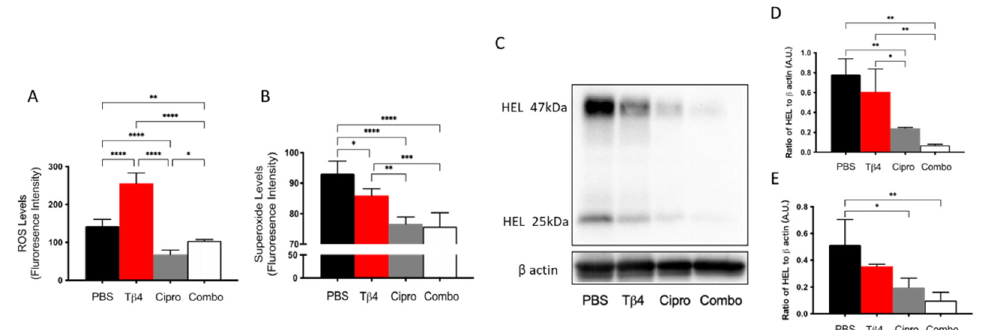
Figure 3. In vivo assessment of oxidative stress in corneal lysates following 3 days of P. aeruginosa - induced infection. Results for ROS ( A ) and superoxide production ( B ) are presented as mean fluorescence intensity ± SD. Western blot was used to detect the reactive species-induced lipid peroxidation damage as determined by HEL adduct formation ( C ). Densitometric analysis of HEL adducts formed at approximately 47 kDa ( D ) and 25 kDa ( E ). Data shown are representative of three independent experiments and normalized to β -actin ± SD. n = 3 corneas/group; * p < 0.05; ** p < 0.01; *** p < 0.001; and **** p < 0.0001.